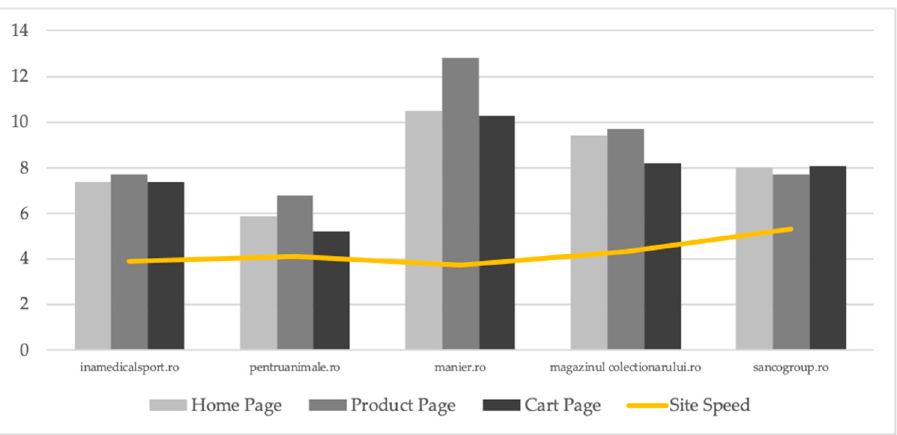
Figure 1. The cases of retailers that presents changes in loading speed during customer journey in 3G network.